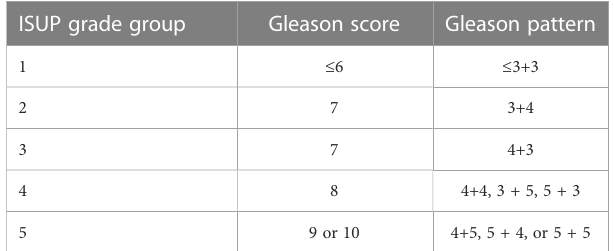
TABLE 1 ISUP grade groups and the corresponding Gleason scores and